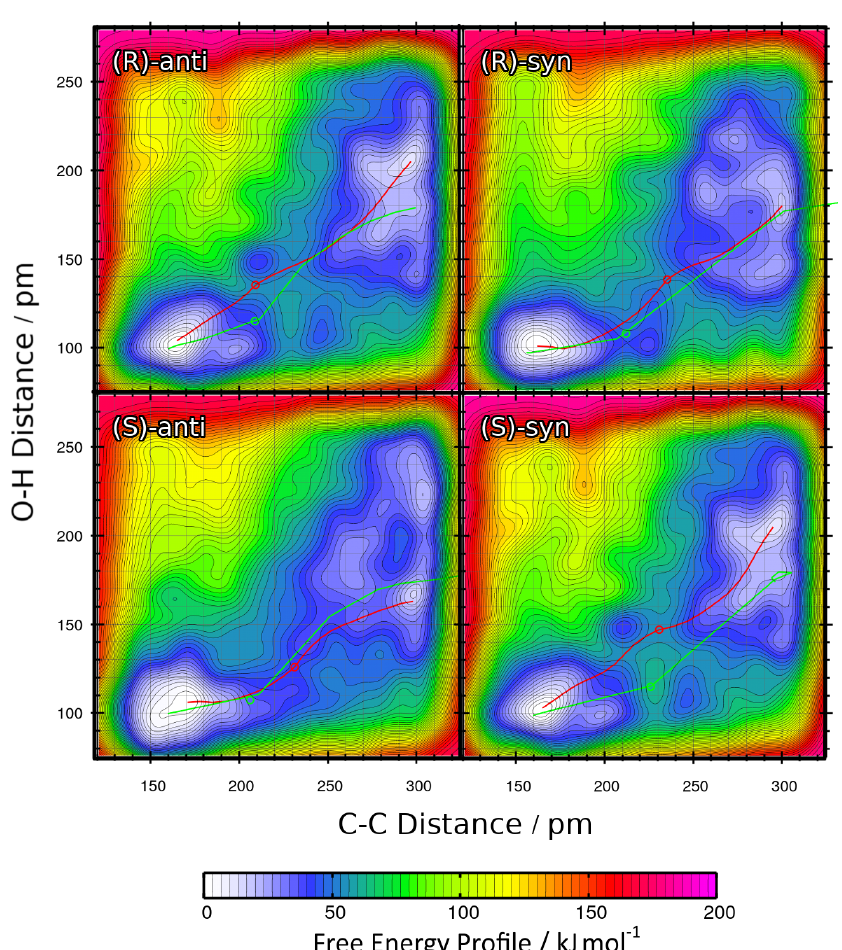
Figure 8. Free energy profiles of the aldol reactions (R=Et) in DMF computed from HyAIMD metadynamics; definition of collective variables see Figure 2b. Red curves depict the minimum energy paths from educts (upper-right energy basin) to products (lower-left energy basin). Green curves show the results of static NEB calculations for comparison. Green circles denote the statically determined transition state.